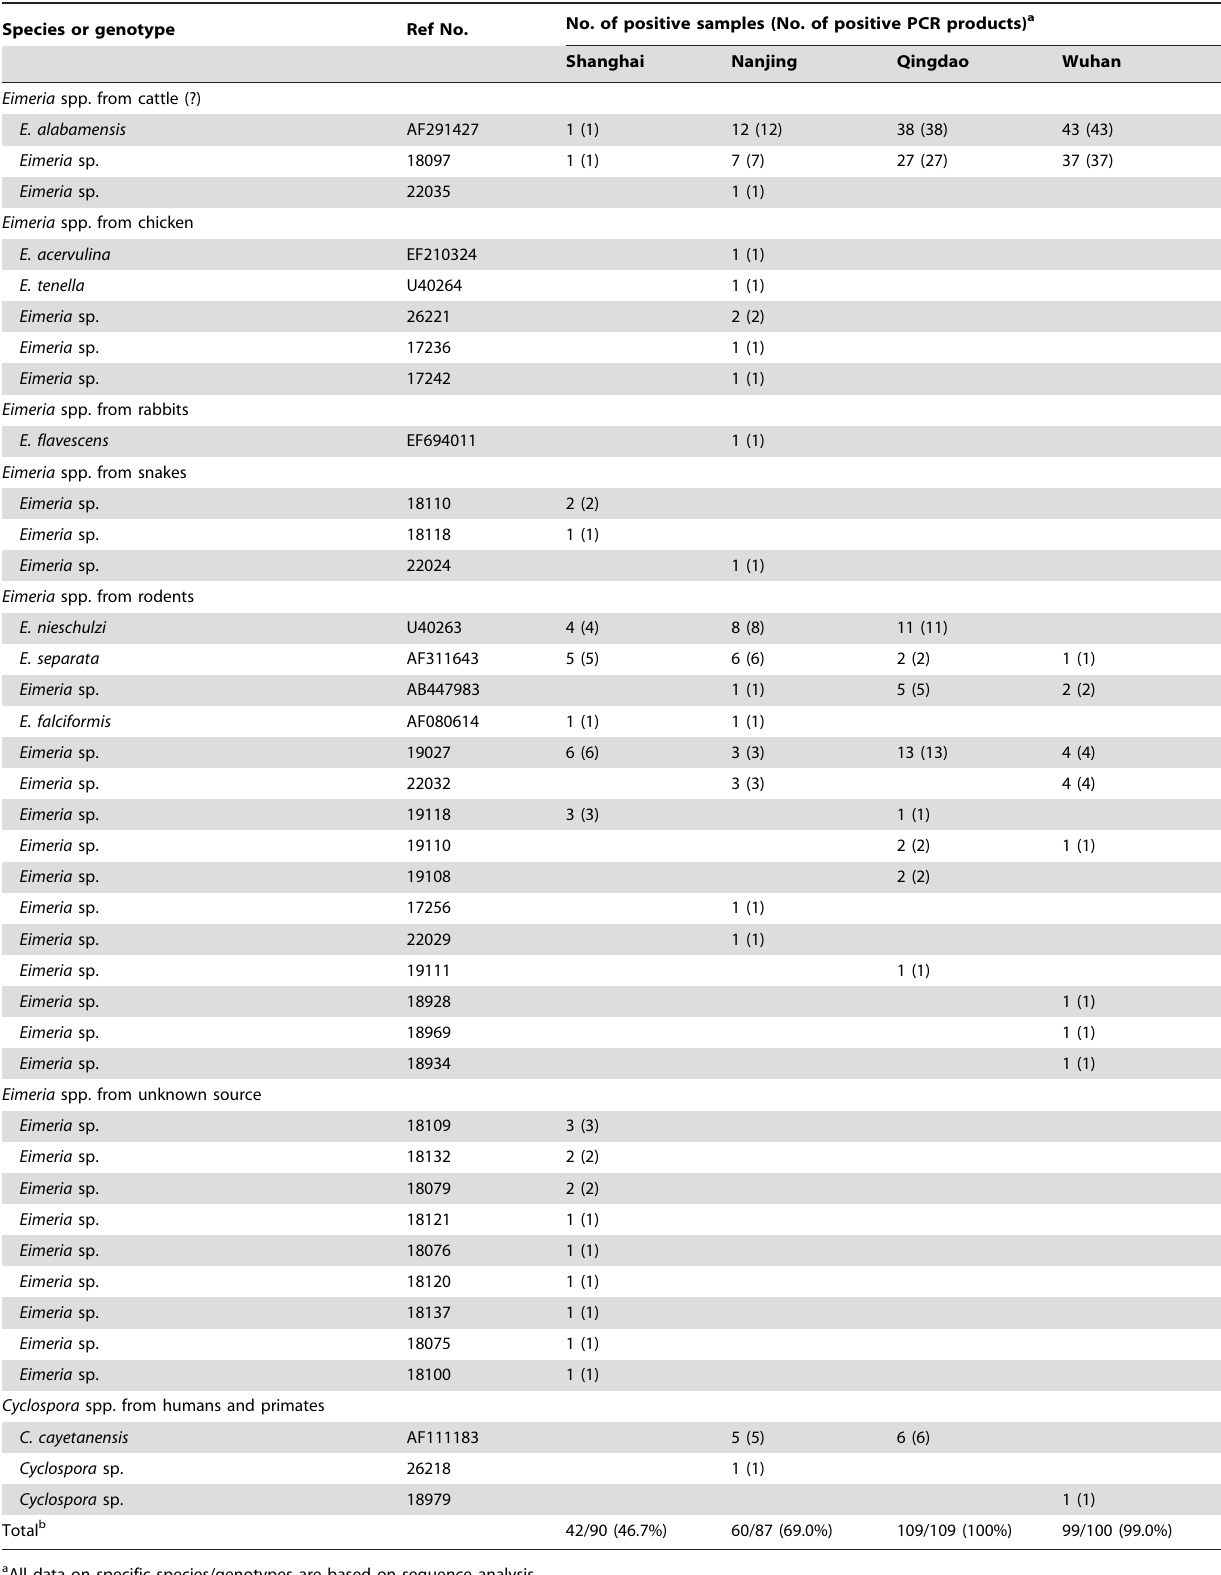
Species or genotype Ref